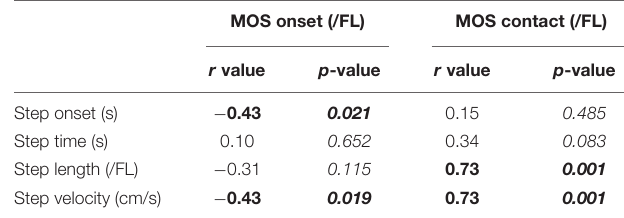
TABLE 4 | Correlation of MOS measures with step